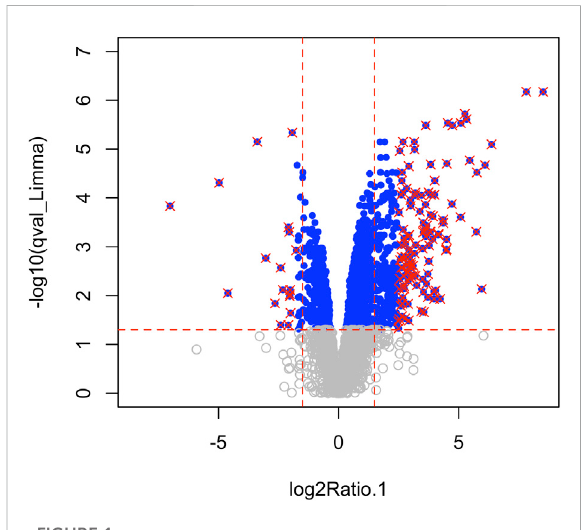
FIGURE 1 Mass spectrometry revealed 3,134 proteins, of which 1,277 were considered differentially regulated (q-value < 0.05; blue points) and of these, 137 proteins satis fi ed z-score criteria (±1.96; red